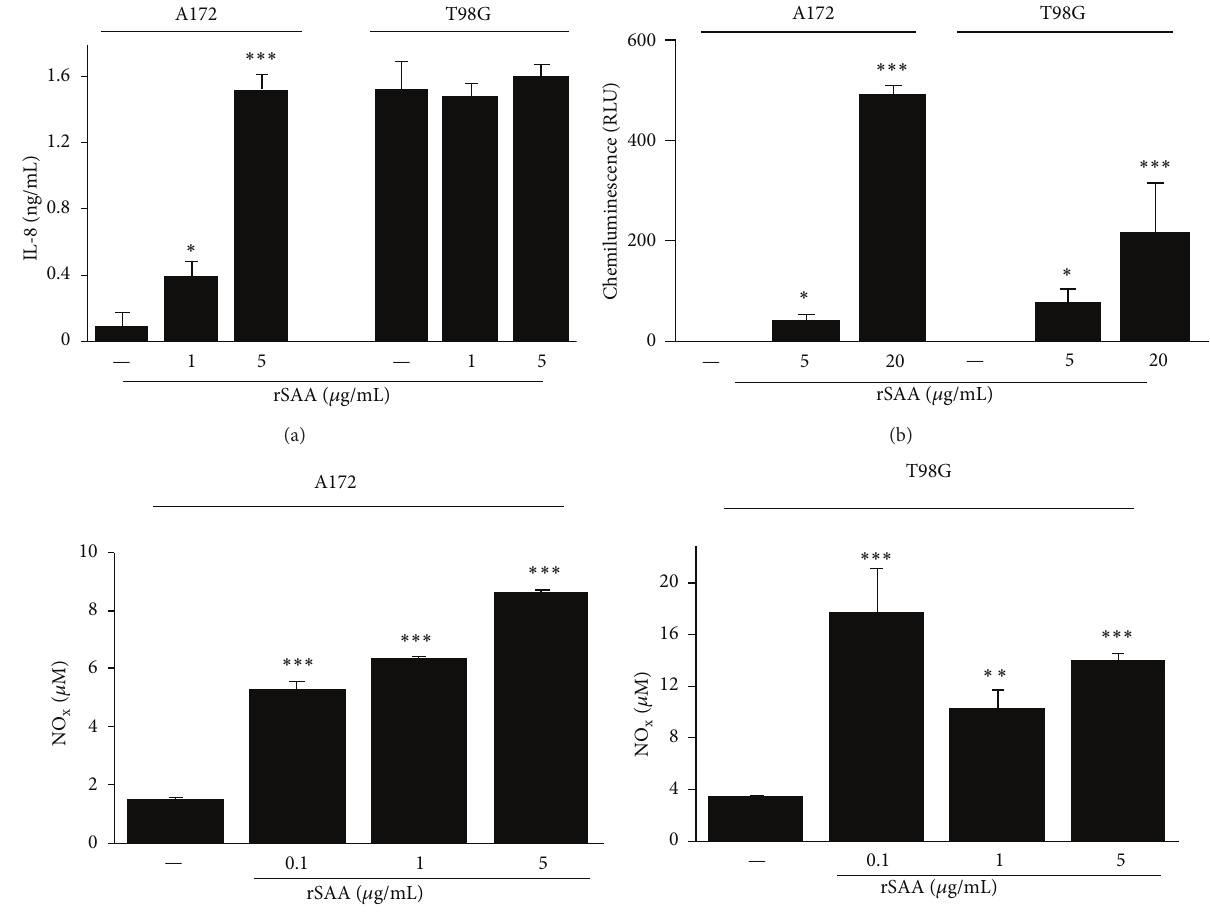
Figure 5: rSAA stimulates the production of relevant molecules in the tumor microenvironment. (a) rSAA (1 and 5 𝜇 g/mL) stimulates the production of IL-8 in a dose-dependent manner by A172 but not by T98G cells. (b) Dose dependence effect of rSAA (5 and 20 𝜇 g/mL) on O 2− anion production as measured by lucigenin-enhanced chemiluminescence in gliomas. (c) SAA stimulates the production of NO in glioma cell lines even in lower concentrations. Data are mean ± SEM of three independent experiments. ∗ 𝑃 < 0.05, ∗∗ 𝑃 < 0.01 , and ∗∗∗ 𝑃 < 0.001 versus control. NO 𝑥 —nitric oxide